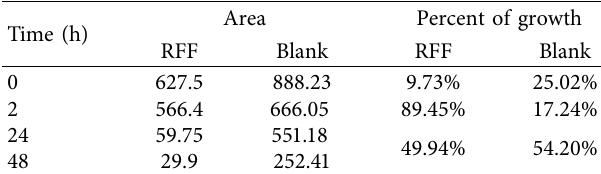
Figure 6: Percent of growth during the experimental procedure. Between 2 and 24h, the RIFF group has the maximum effect (89.45% of scratch closed). Table 2: Calculation of scratch area and percentage of growth at 0, 2, 24, and 48hours after treatment. Percent of growth � (T2 scratch area − T1 scratch area)/T1 scratch area ×